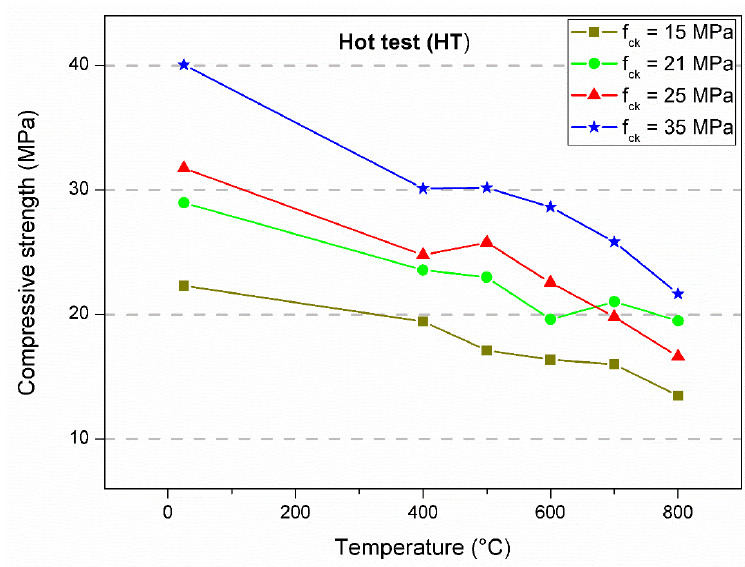
Figure 4. Compressive strength average of specimens tested when hot.